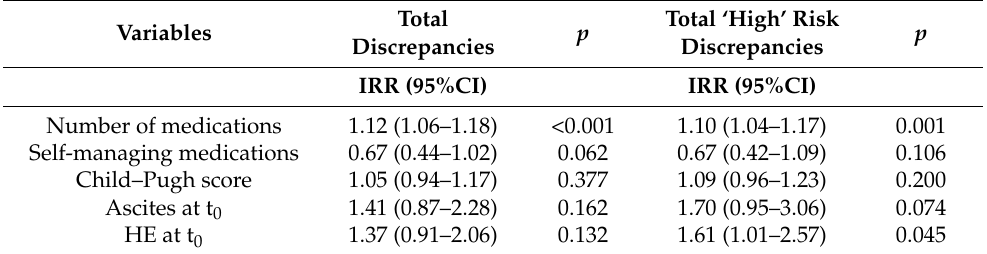
Table 2. Factors associated with medication discrepancies at baseline.